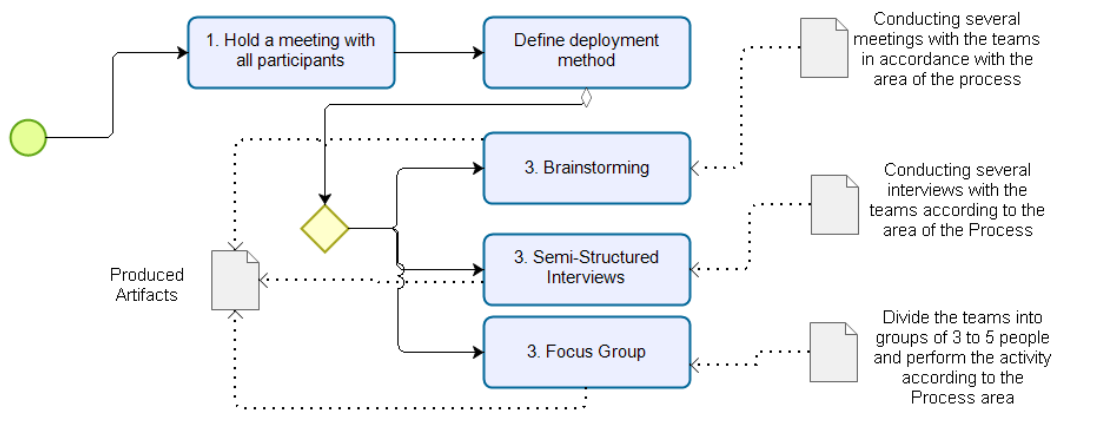
Figure 5. Sub-process